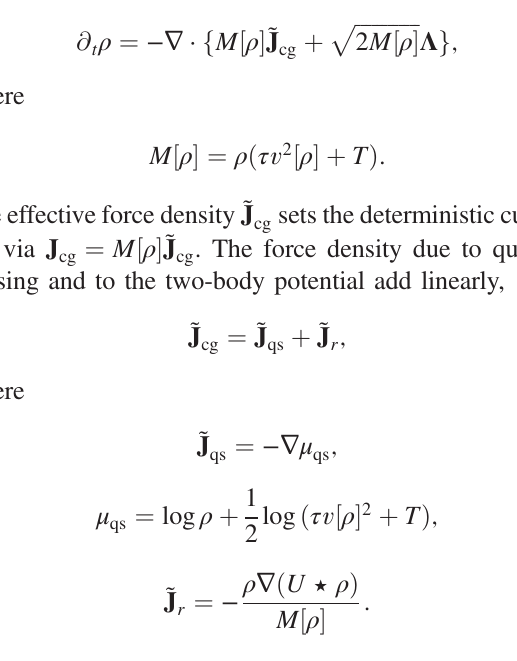
ffiffiffiffiffiffiffiffiffiffiffiffi p 2 M ½ ρ (cid:2) Λ g ; ð 35